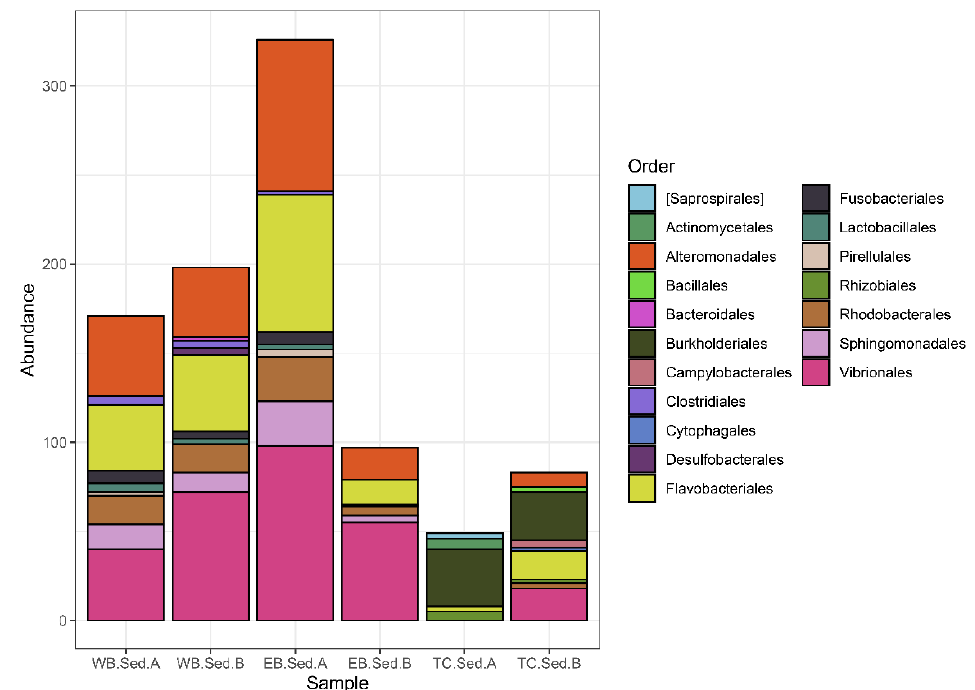
Fig. 5: Sediment profiles at the order level after normalization to the same number of sequences/sample. WB- West Beach; EB- East Beach; TC-Tidal Creek.